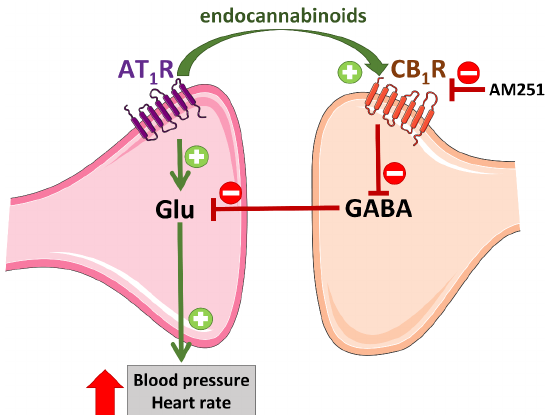
Figure 5. Potential mechanisms of the cross-talk between AT 1 receptors (AT 1 Rs) and cannabinoid type 1 receptors (CB 1 Rs) in the paraventricular nucleus of the hypothalamus. AT 1 R activation increases blood pressure and heart rate due to a direct and indirectly mediated increase in glutamate (Glu) release. The indirect effect involves an inhibitory γ -aminobutyric acid (GABA) interneuron. In detail, AT 1 R activation increases the release of endocannabinoids (mainly 2-arachidonoyl-glycerol) acting at presynaptic cannabinoid CB 1 receptors (CB 1 Rs), activation of which decreases the inhibitory influence of GABA on sympathoexcitatory glutamatergic neurons. On the other hand, the CB 1 R antagonist AM251 blocking presynaptic CB 1 Rs increases the inhibitory influence of GABA on glutamatergic neurons excited by AT 1 R activation, resulting in a decreased Ang II-induced pressor response. Facilitatory influences are shown by green arrows and plus signs, whereas inhibitory effects are represented by red bars and minus